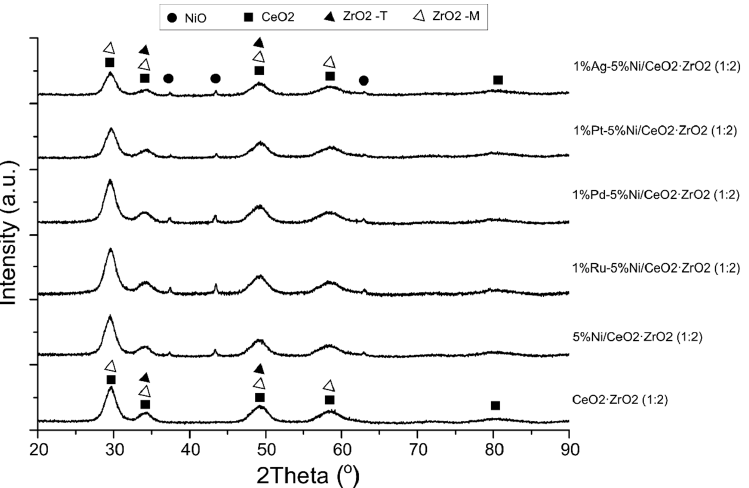
Figure 2. XRD patterns of the investigated support, mono- and bimetallic catalysts calcined in an air atmosphere at 400 °C for 4 h.